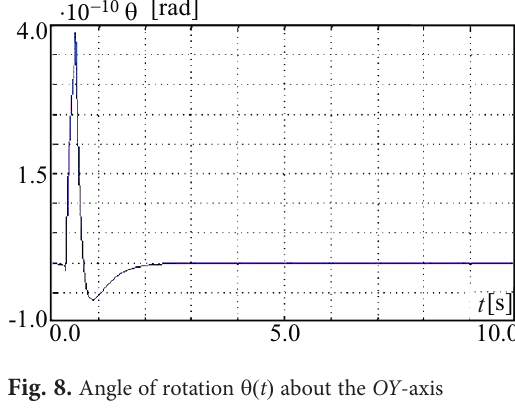
Fig. 8. Angle of rotation θ( t ) about the OY -axis